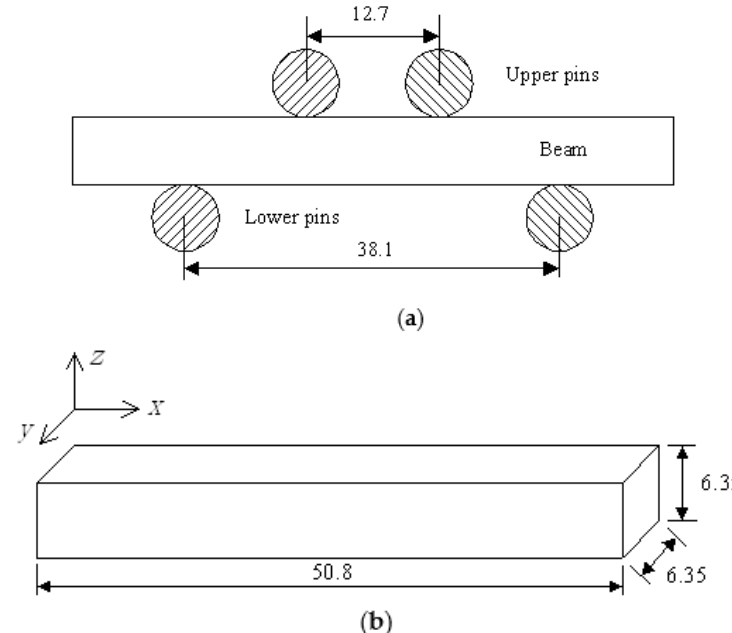
Figure 10. Schematic diagram of ( a ) layout of four-point bend test; ( b ) geometric shape and dimensions of bend beam (unit: mm).